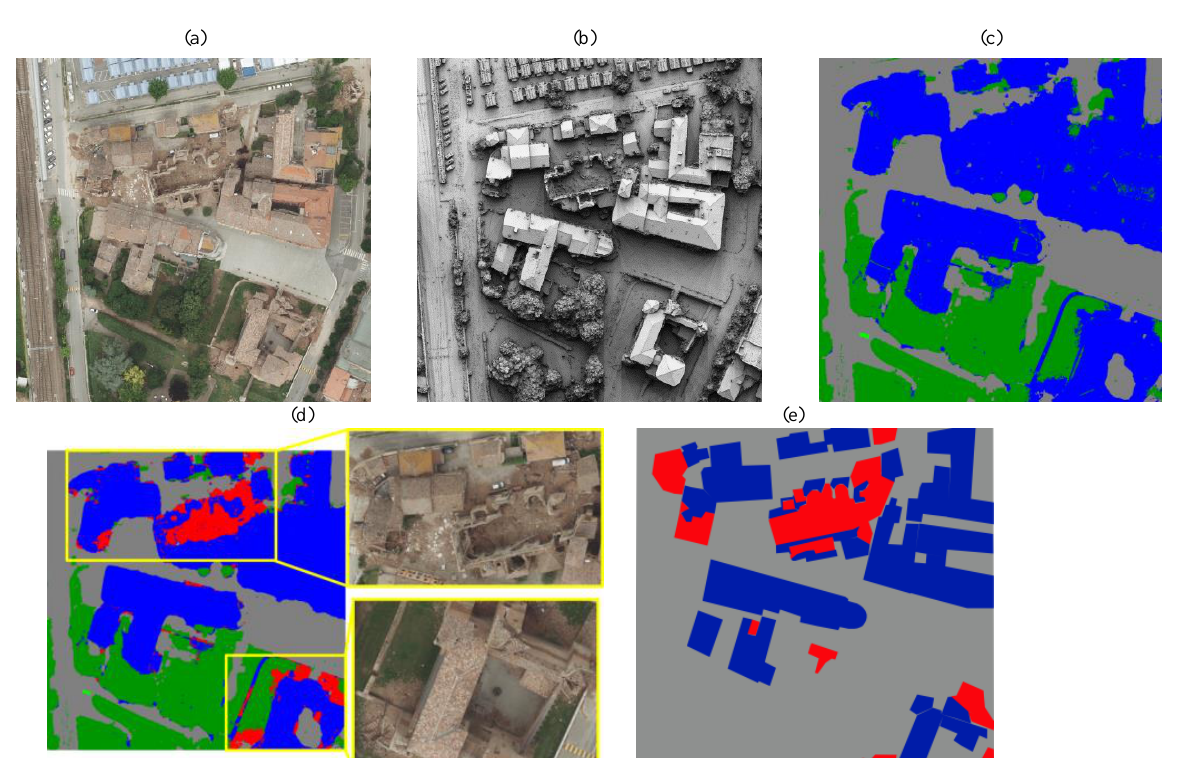
Figure 2: True orthophoto (a) generated from the extracted DSM (b) of Area 1. Results of the urban classification (c) with four classes: low vegetation (light green), high vegetation (dark green), ground (gray), building (blue). Automatically detected damaged buildings and the created classification map (d) - with close-up views on the original imagery: damaged (red), intact (blue). Manual identification of damaged / intact buildings (e).